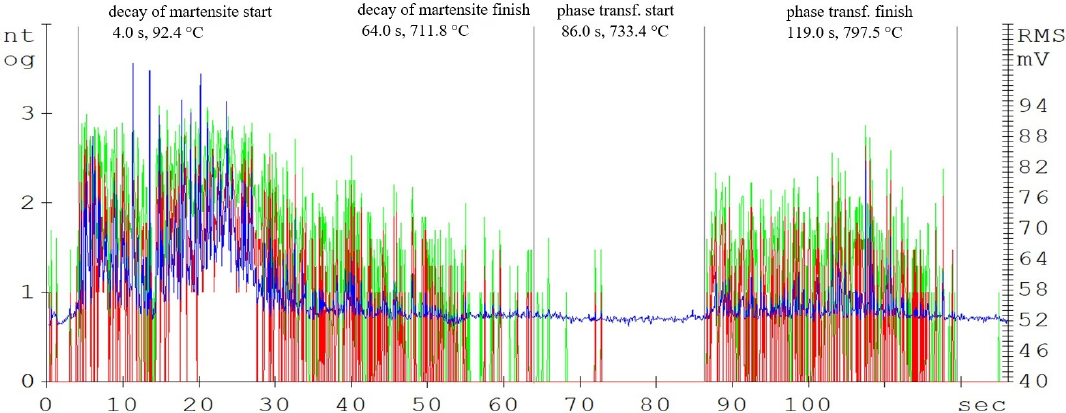
Figure 5. Acoustic emission spectrogram for the C105W1 steel samples, with a heating temperature of 800 °C. (Count 1: green, Count 2: red, RMS: blue).